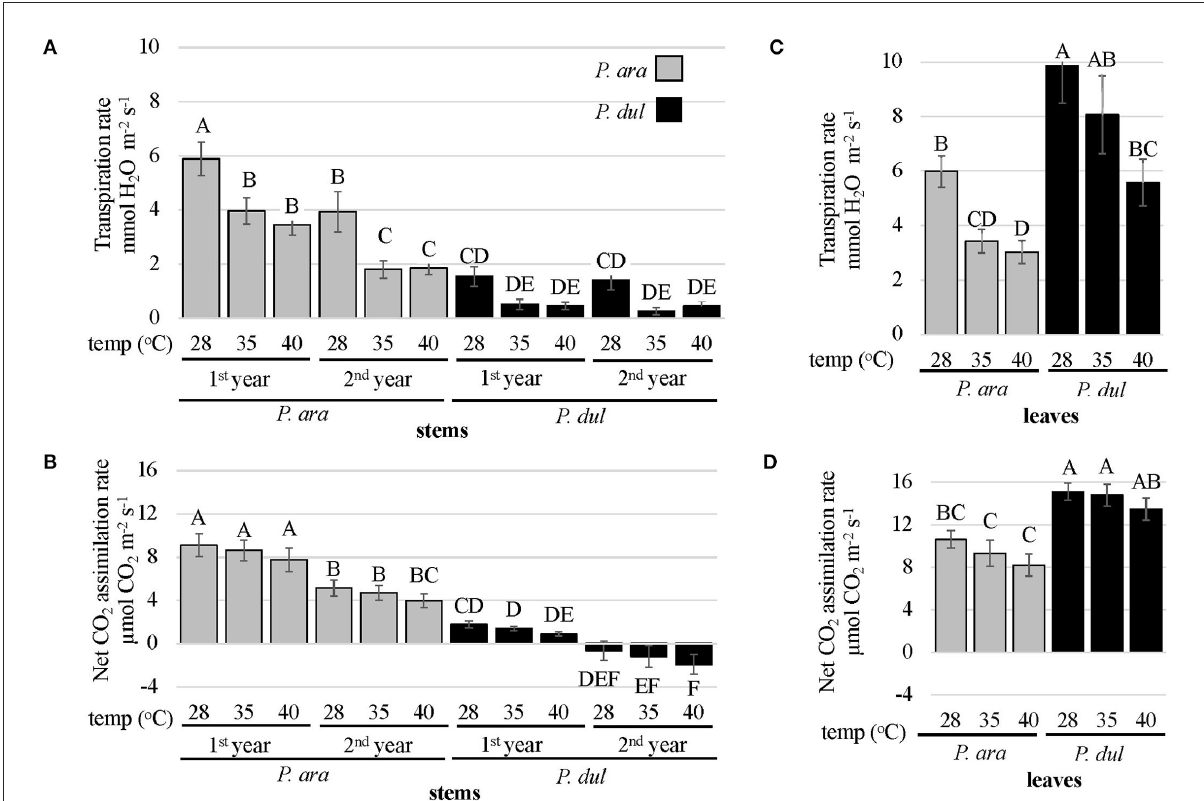
FIGURE6 Gas exchange measurements of leaves and stems of P. arabica and P. dulcis. Gas exchange measurements of leaves and stems of P. arabica and P. dulcis were performed during the summer season under varied controlled temperatures (28, 35, 40 ◦ C). (A) The stem transpiration rate (E) full factorial analysis of variance was significant ( R 2 = 0.64, p < 0.0001). Stem E rates between almond species, stem age, or under different temperatures were highly significant ( p < 0.0001 for each). The interaction between almond species and stem age was also significant ( p